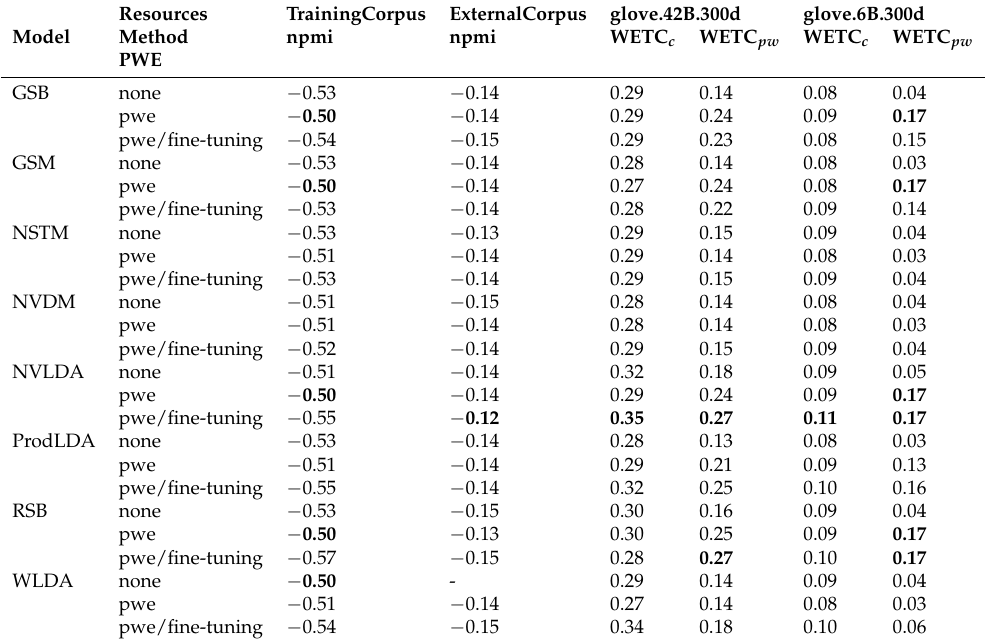
Table 12. Topic Coherence on